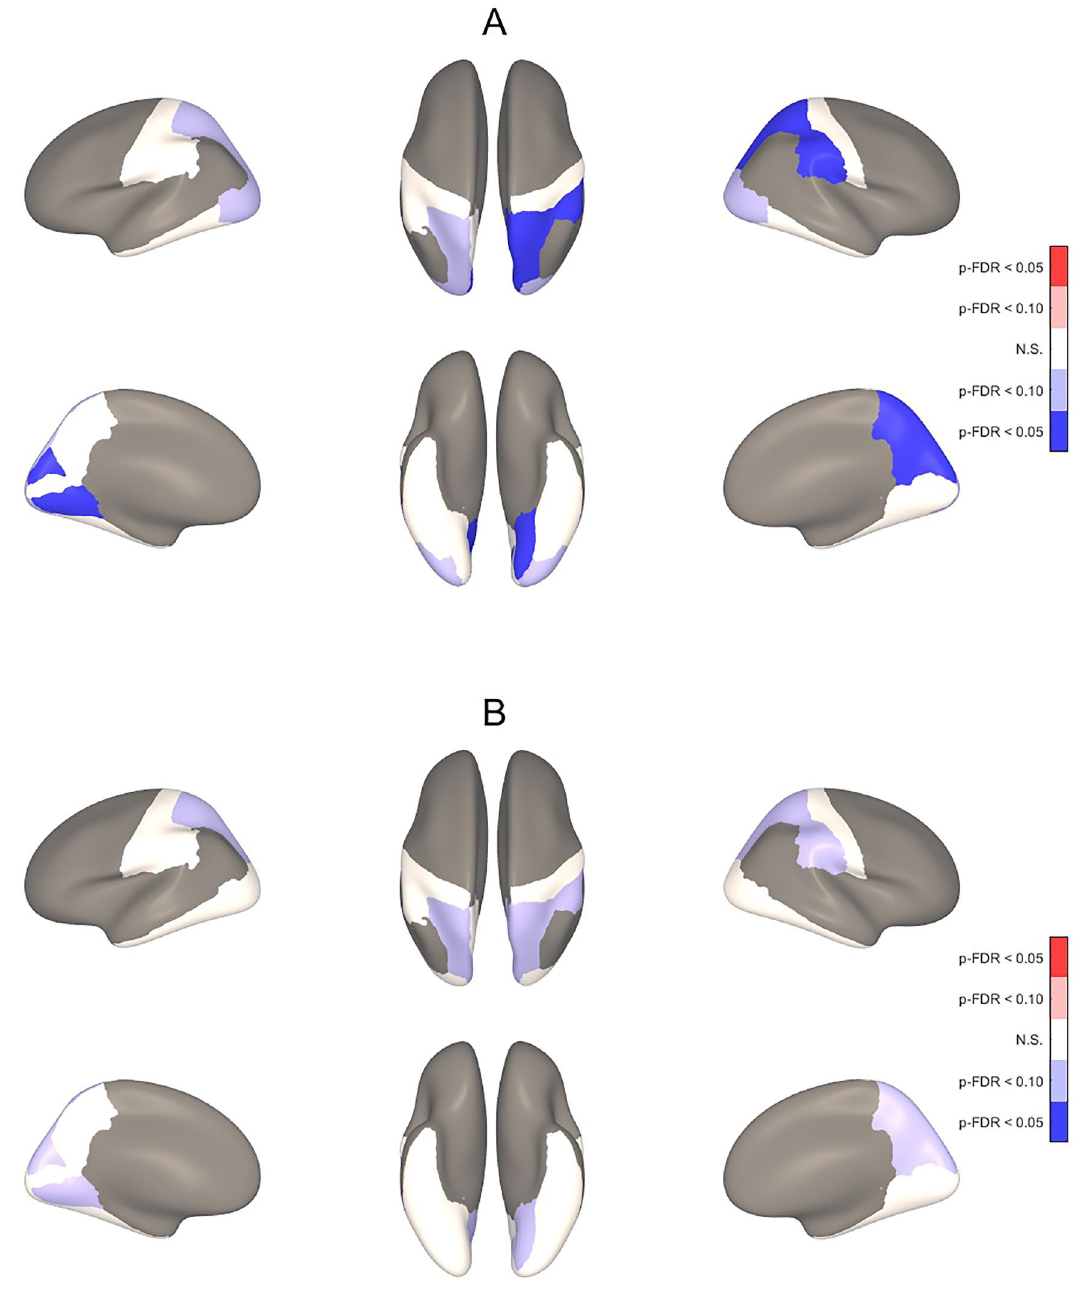
Figure 3. 3-D Maps Showing Correlation Between ScreenQ Scores and Cortical Thickness for Defined Regions of Interest. Three-dimensional maps showing correlations between ScreenQ total scores and cortical thickness for defined regions of interest (ROIs), controlling for age and sex ( A ) and also for maternal education ( B ). These are displayed on an inflated brain for better visibility of clusters, with blue representing thinner cortex. Upper views are lateral and superior, lower views are medial and inferior, with the frontal lobe facing upward. Effect sizes and FDR-corrected p-values for these ROIs in ( A ) and ( B ) are detailed in Table